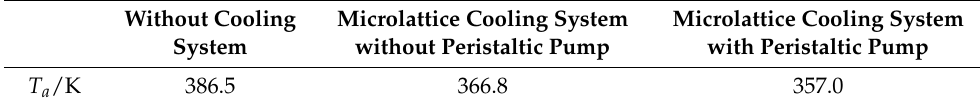
Figure 8. Test results of the heat dissipation performance of the cooling system. Table 4. Results of the experiment Table 4. Results of the experiment.